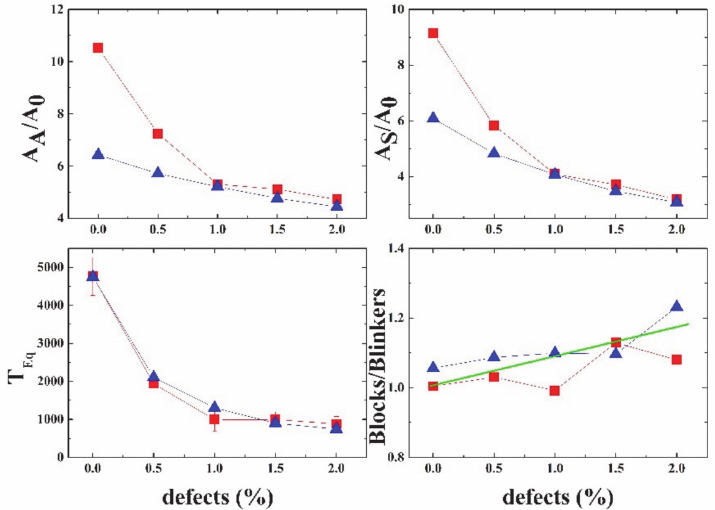
Figure 17. (Color on line) Dependence on the percentage of defects of several properties. For initial densities ρ i = 15%: Top Left: Active area, A A , divided by the initial area A 0 . Top Right: Spiked area A S , divided by A 0 . Bottom left: Equilibration time, bottom right, ratio #blocks/#blinkers. Straight line represents the linear fit of both results. Red squares and blue triangles are the results using open and closed boundaries,